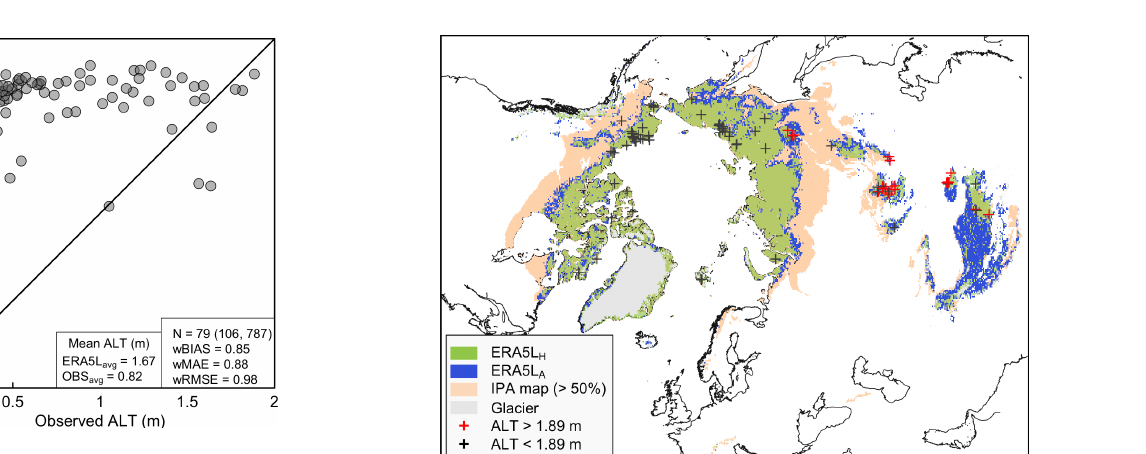
Figure 4. Comparison of active-layer thicknesses (ALT) based on 787 measurement from 106 stations located in 79 grids. The ob- served sites are mainly located in high latitudes, and the distribution is present in Fig. 5. The comparison is limited to sites with shallow active layers ( < 1 . 89m).